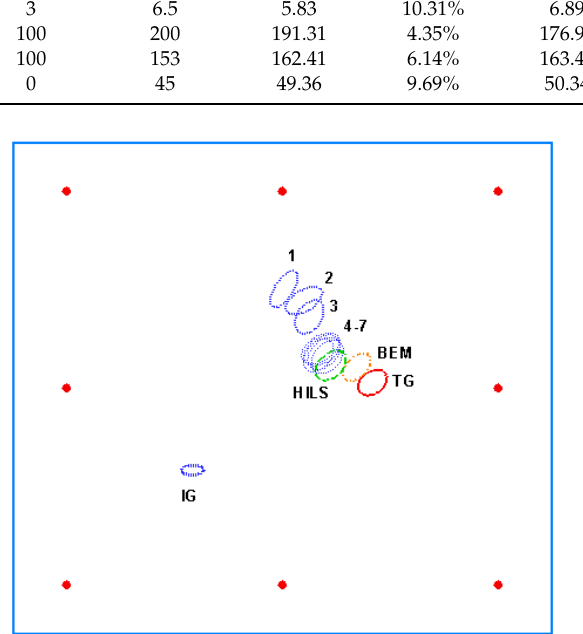
Figure 10. Procedures of hole identification by using multiple loading modes. Red points are sensor positions. The marked number signifies these seven identified processes.